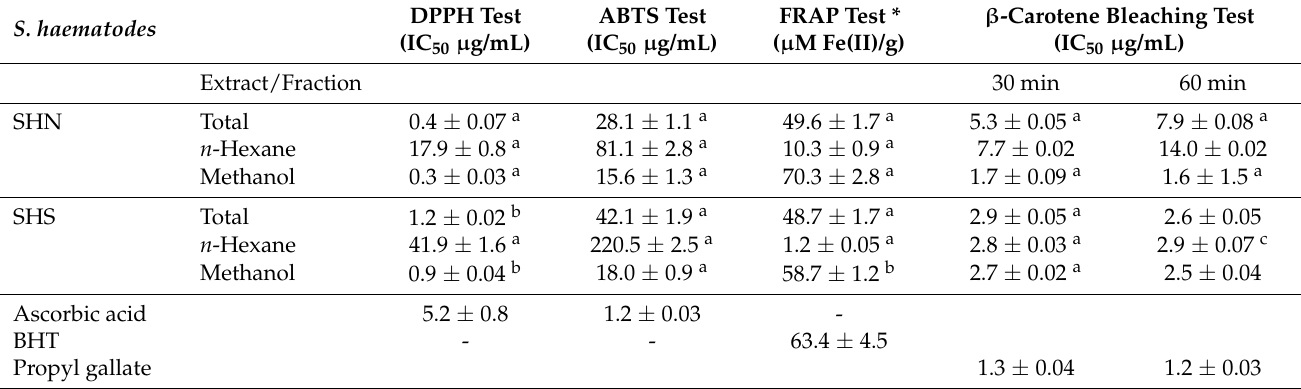
Table 3. In vitro antioxidant activity of S. haematodes .